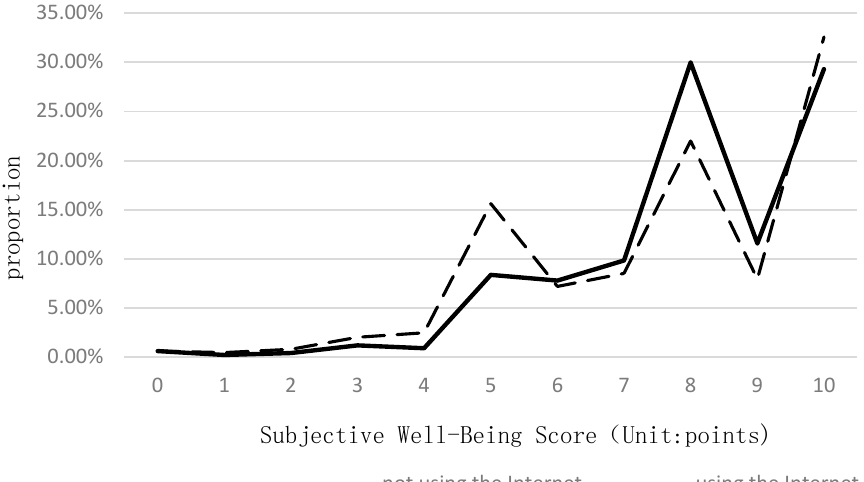
not using the Internet using the Internet Figure 3. Internet use and subjective well-being scores of the Figure 3. Internet use and subjective well-being scores of the elderly.